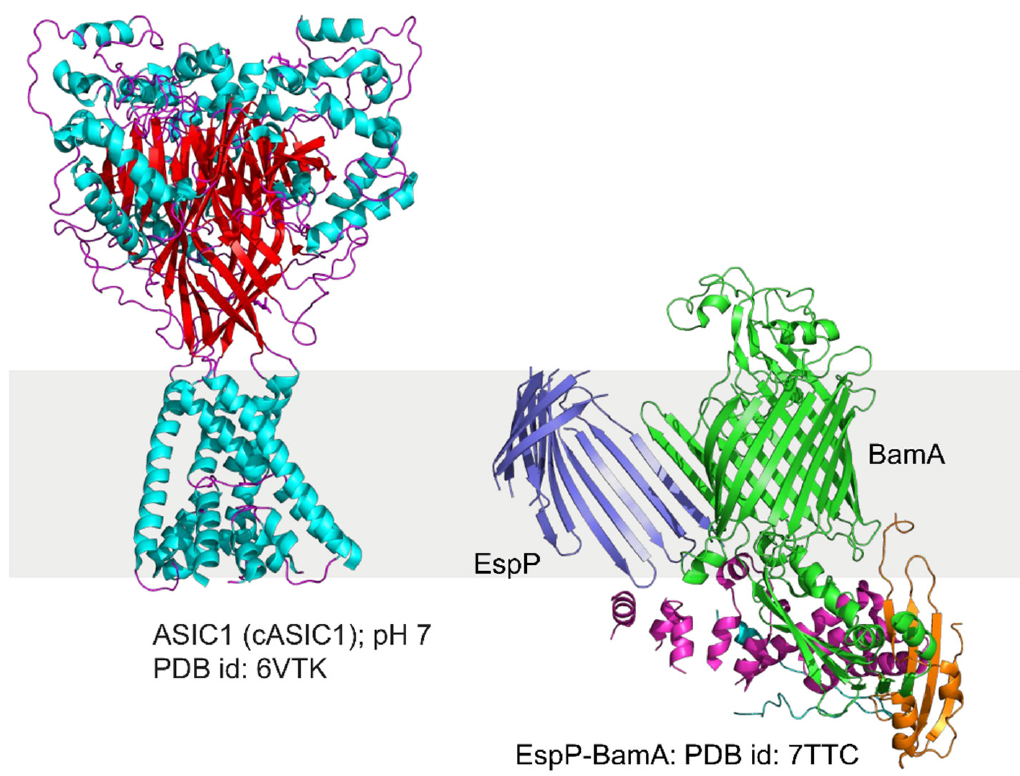
Figure 8. The structure of alternative Complex III (PDB id: 6BTM) from Flavobacterium johnsoniae [184], AcrB (PDB id: 6BAJ) from E. coli (K-12) [182], KimA (PDB id: 6S3K) from Bacillus subtilis [157], HwBr (PDB id: 5ITC) from Haloquadratum walsbyi [119], cytochrome bo3 (PDB id: 7CUQ) from E. coli [171], SLAC1 (PDB id: 7EN0) from Brachypodium distachyon SLAC1 [173], bacterial pLGIC (PDB id: 7L6Q) [172], the glycine receptor open conformation (PDB id: 6PM6; the Gly residues are shown in red spheres) and taurine-bound closed conformation (top view) (PDB id: 6PM3; taurine is shown in blue spheres) from zebrafish [185]. The 6PM3 structure is shown with 50% transparency to highlight taurine. ASIC1 (PDB id: 6VTK) from chicken [186], and EspP-BamA complex structure (PDB id: 7TTC) from E. coli [136]. The structures were generated using PyMOL.